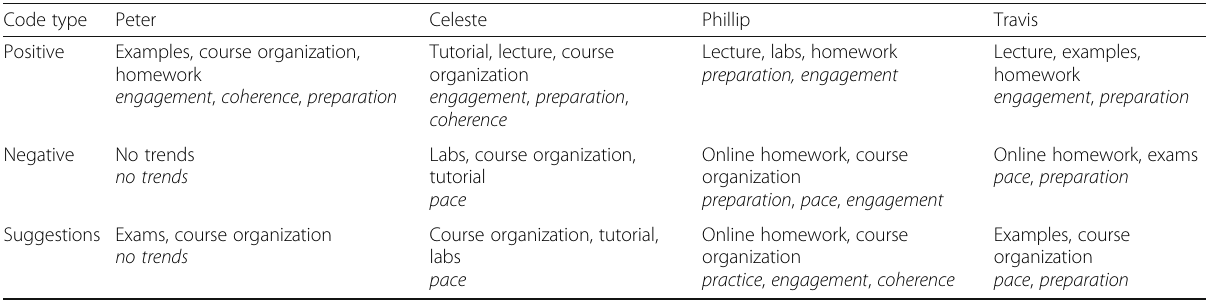
Table 6 Summary of codes from SALG data. First level (what?) codes are in normal text, and second level (why?) codes are in italics Code